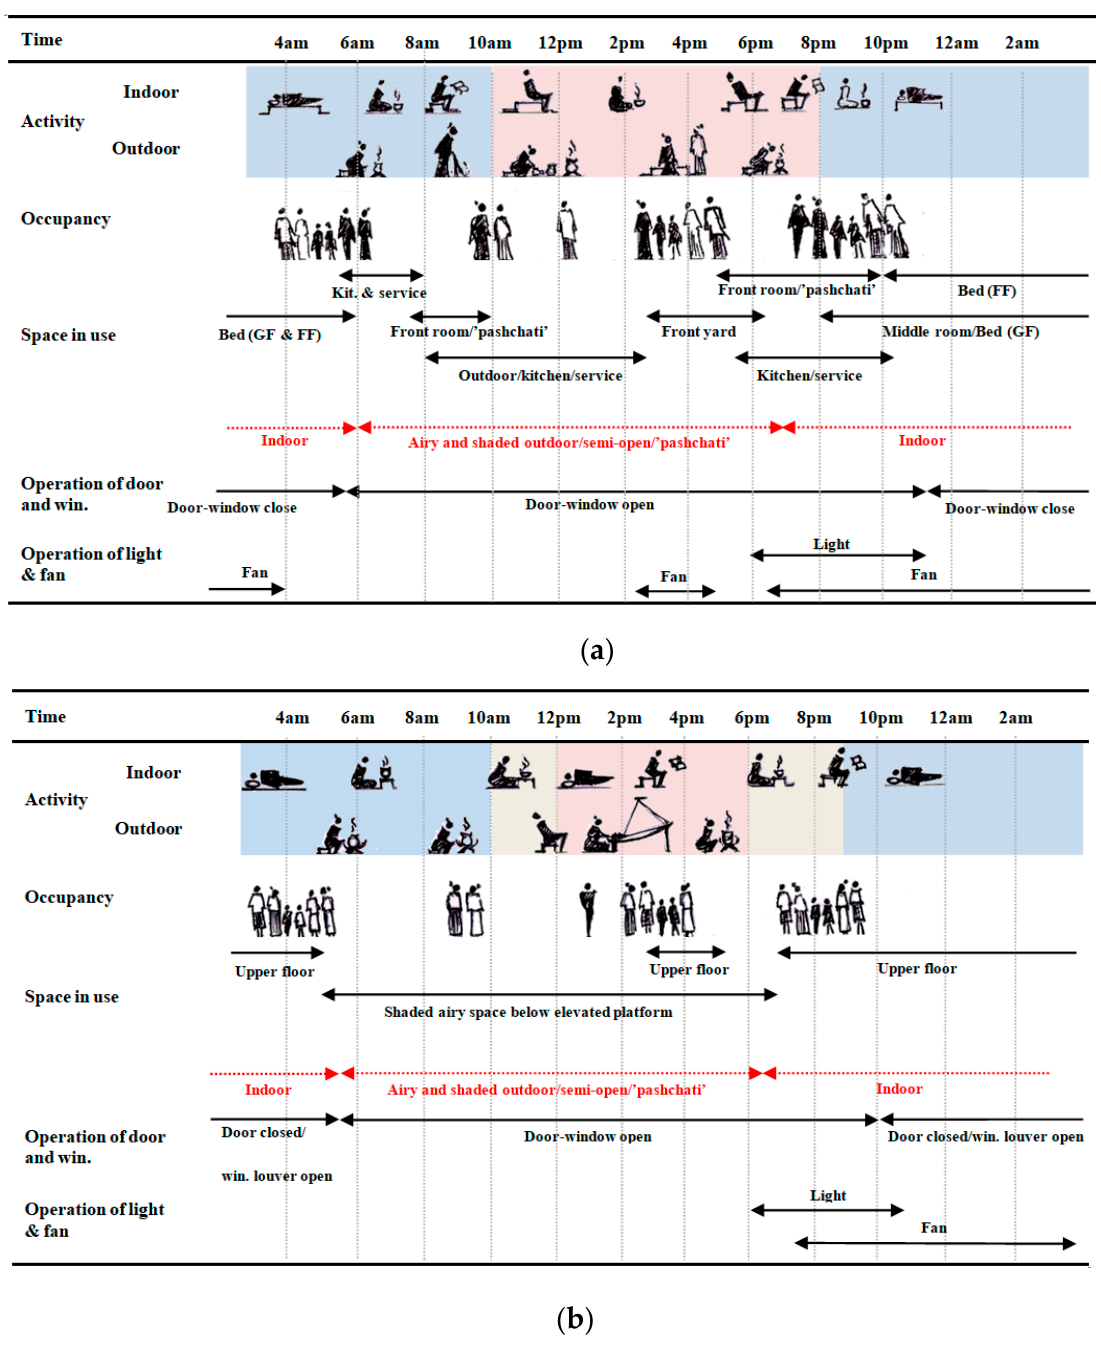
Figure 13. Relationship between indoor thermal experience and occupant’s living pattern in traditional timber houses: ( a ) single/double-storied house; ( b ) stilt house; Note: Responses nearly 50% or above: ( − 3 to − 1) (0) (+1 to +3).